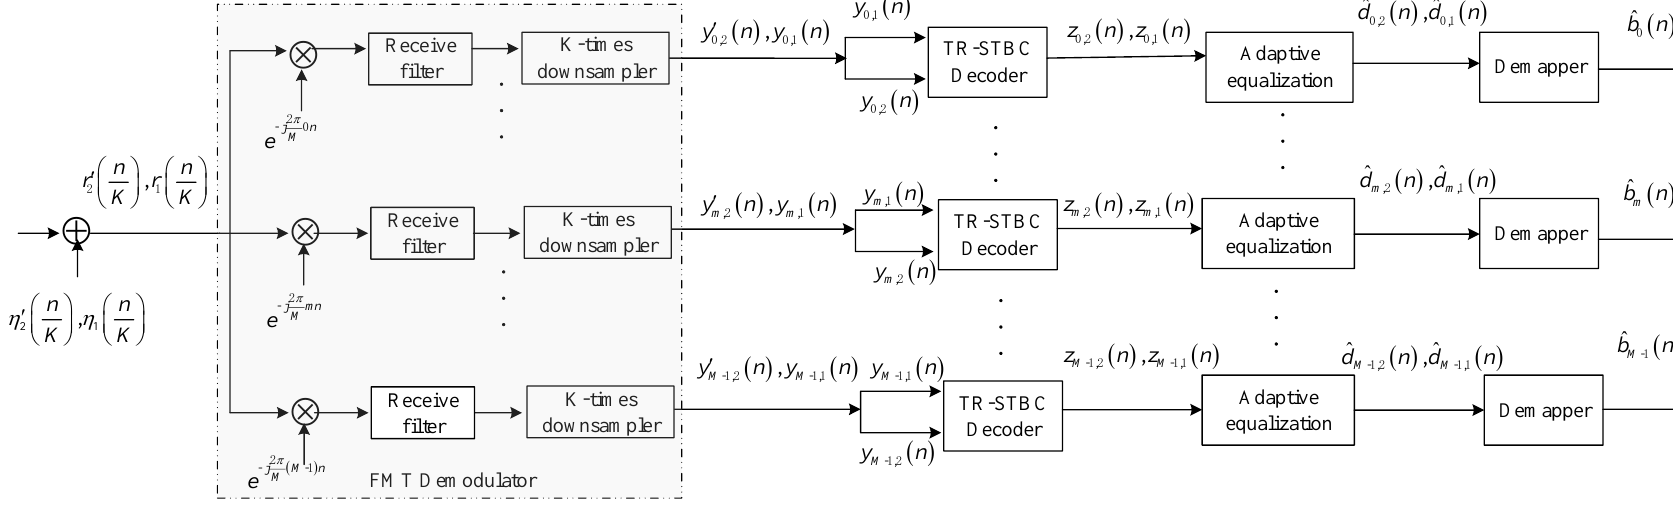
Figure 2. Block diagram for receive structure.